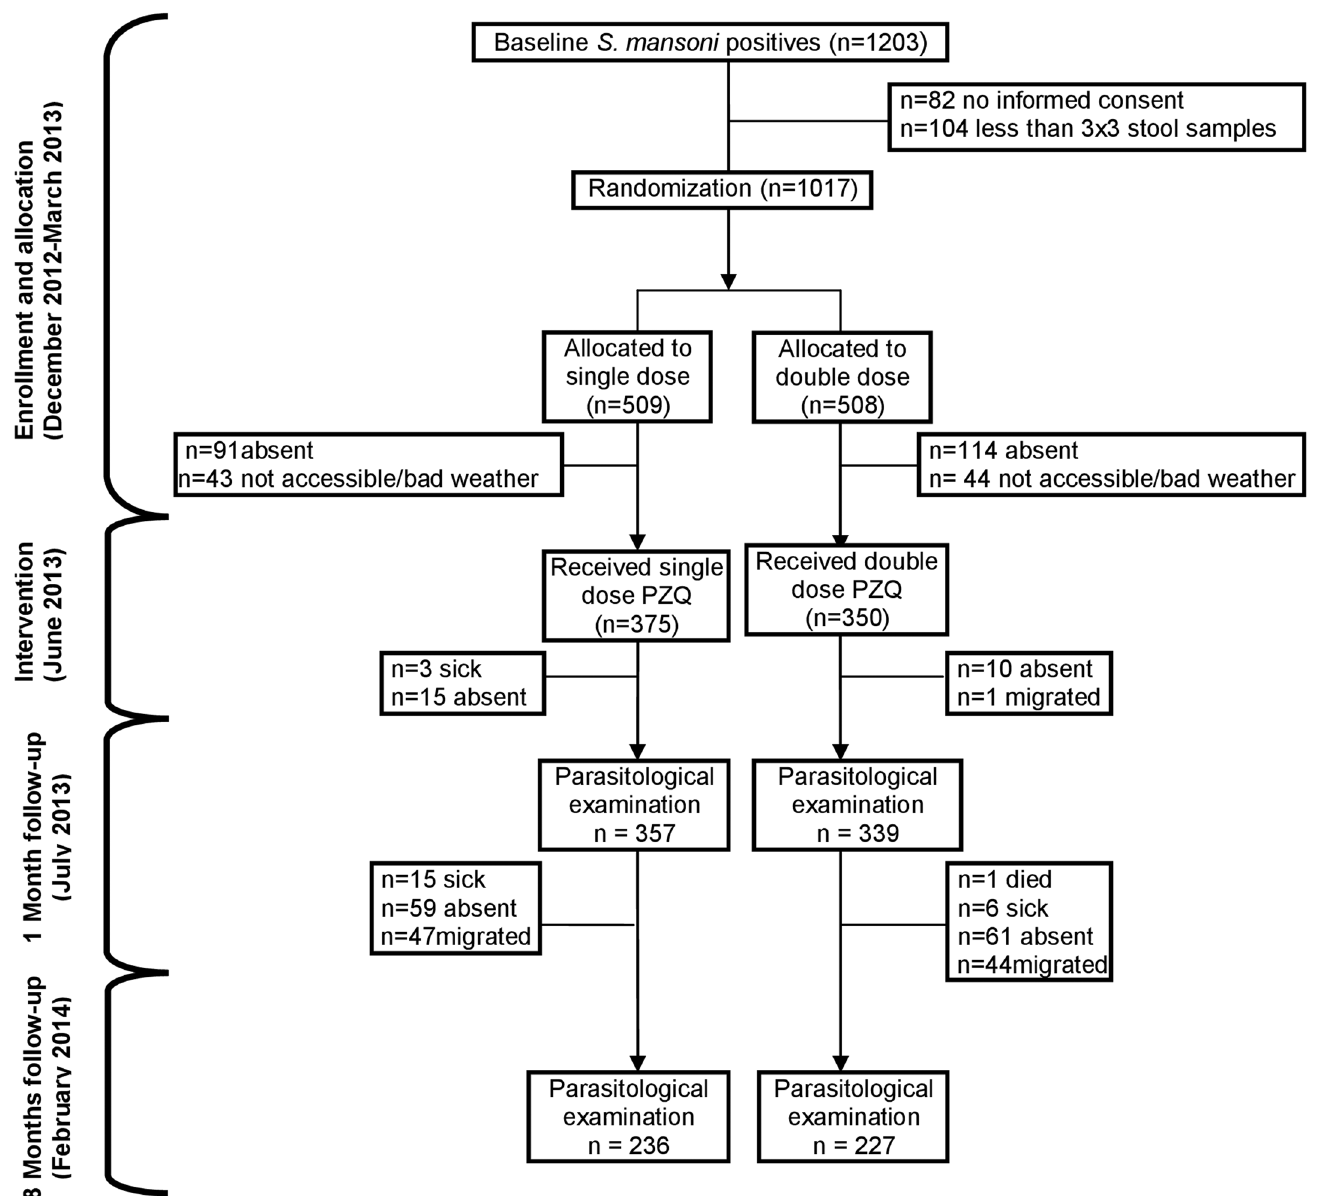
Fig 2. Enrollment, randomization, follow-up, and inclusion in the final analysis in the study comparing single and double dose PZQ treatment